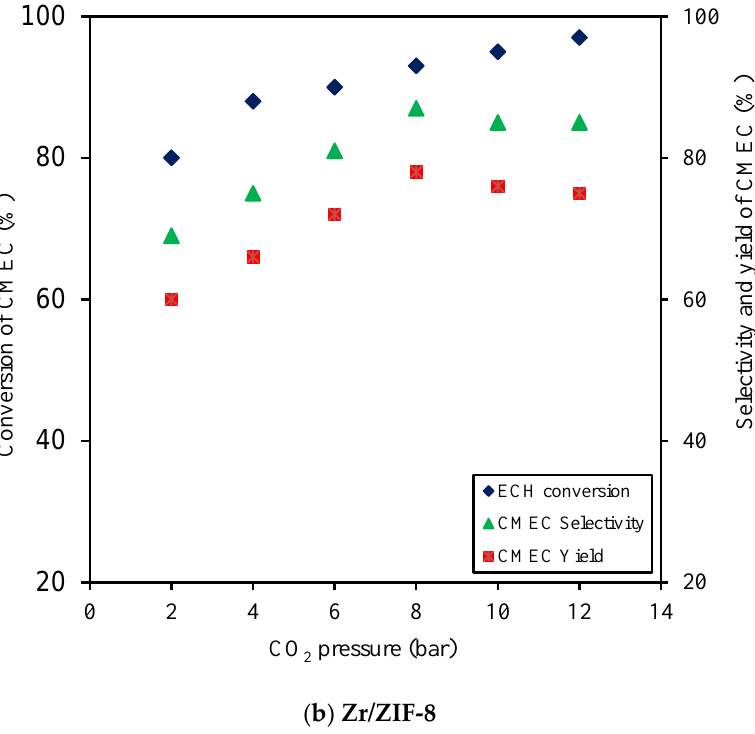
Figure 14. Pressure dependence on conversion of ECH versus selectivity and yield of CMEC. Experimental conditions: catalyst ( a ) ZIF-8 and ( b ) Zr/ZIF-8; catalyst loading 10% ( w/w ); reaction time 8 h; reaction temperature 353 K; stirring speed 350 rpm.